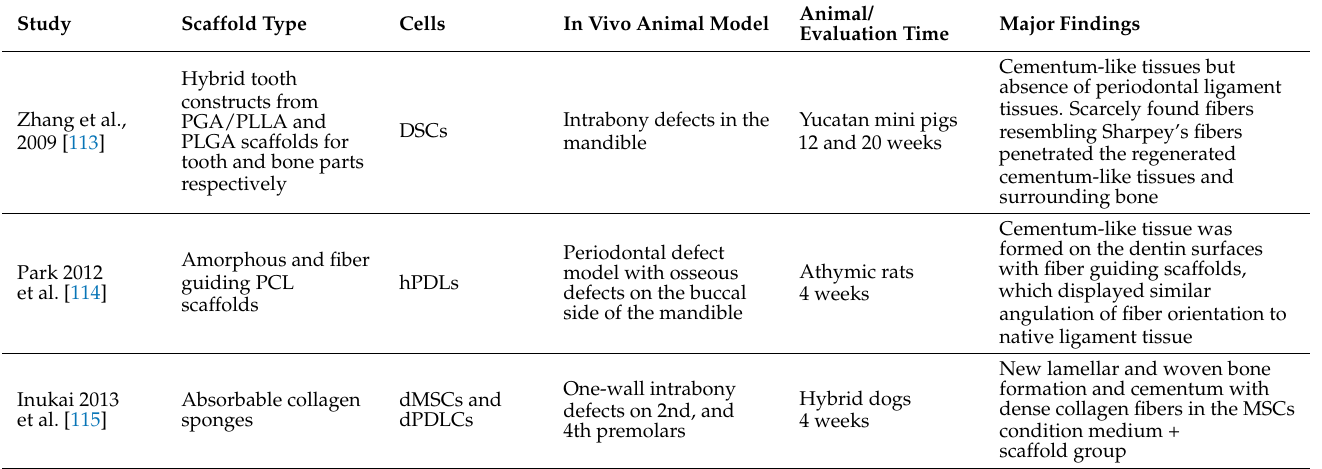
Table 2. In vivo studies evaluating scaffolds for PDL regeneration employing the periodontal defect